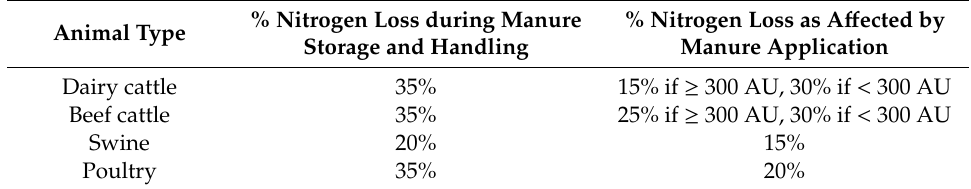
Table 4. Nitrogen Loss during Manure Storage and Application by Animal